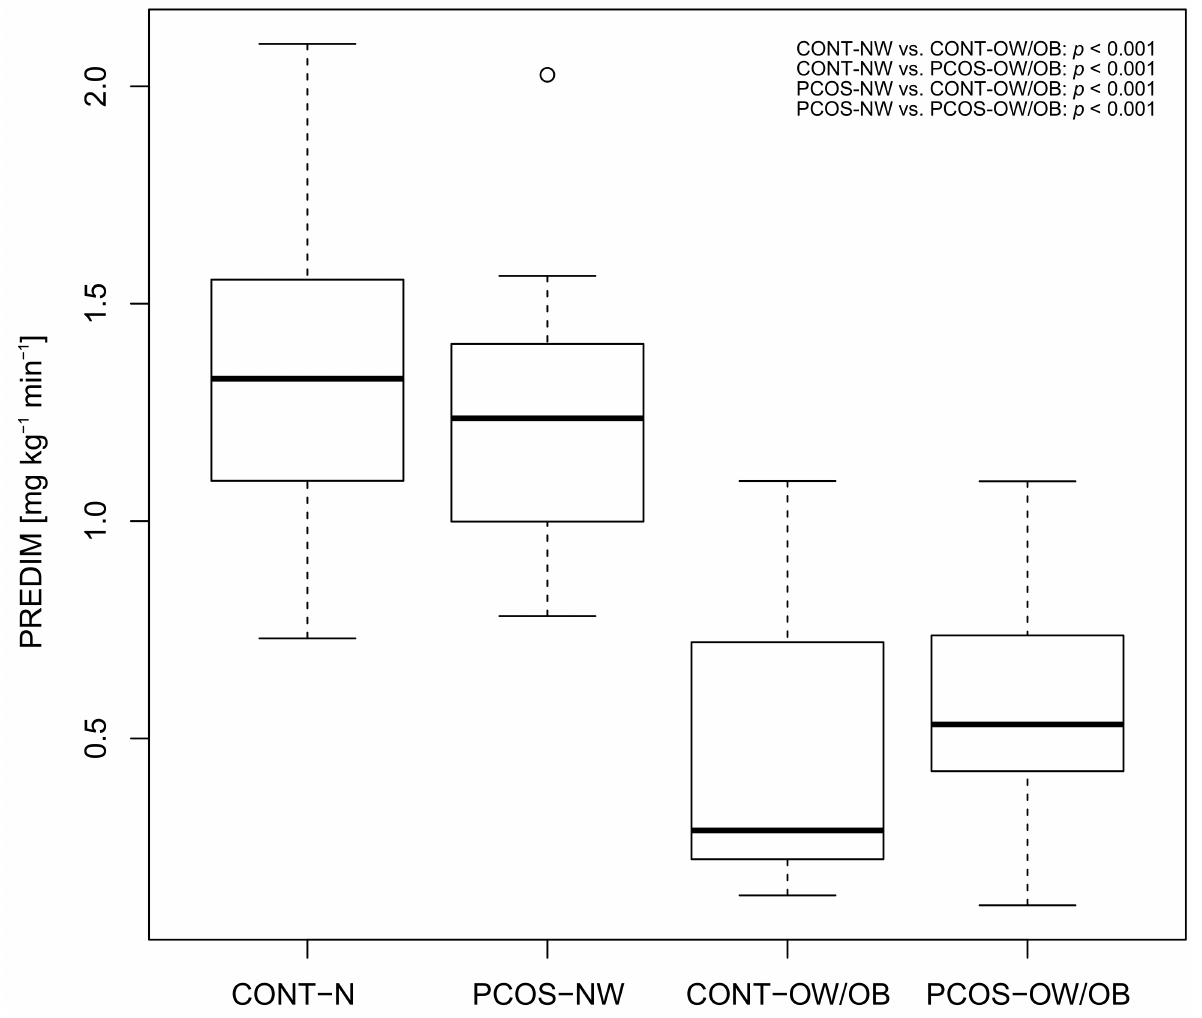
Figure 1. Box-whisker plot for whole body insulin sensitivity assessed by PREDIM. Abbreviations Figure 1: CONT-NW: normal weight controls; CONT-OW/OB: overweight or obese controls; PCOS-NW: normal weight PCOS; PCOS-OW/OB: overweight or obese PCOS; PREDIM: Predicted